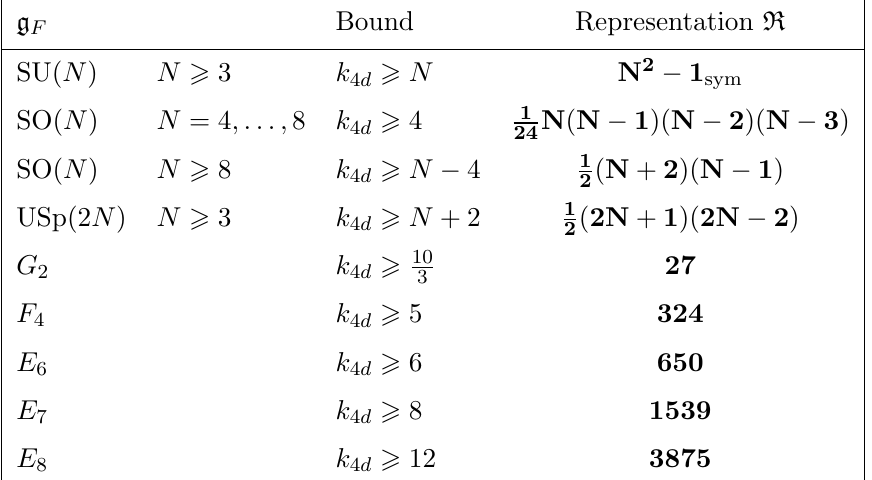
Table 2 . Unitarity bounds for the anomaly coefficient k 4 d arising from positivity of the ˆ point function in non-singlet channels